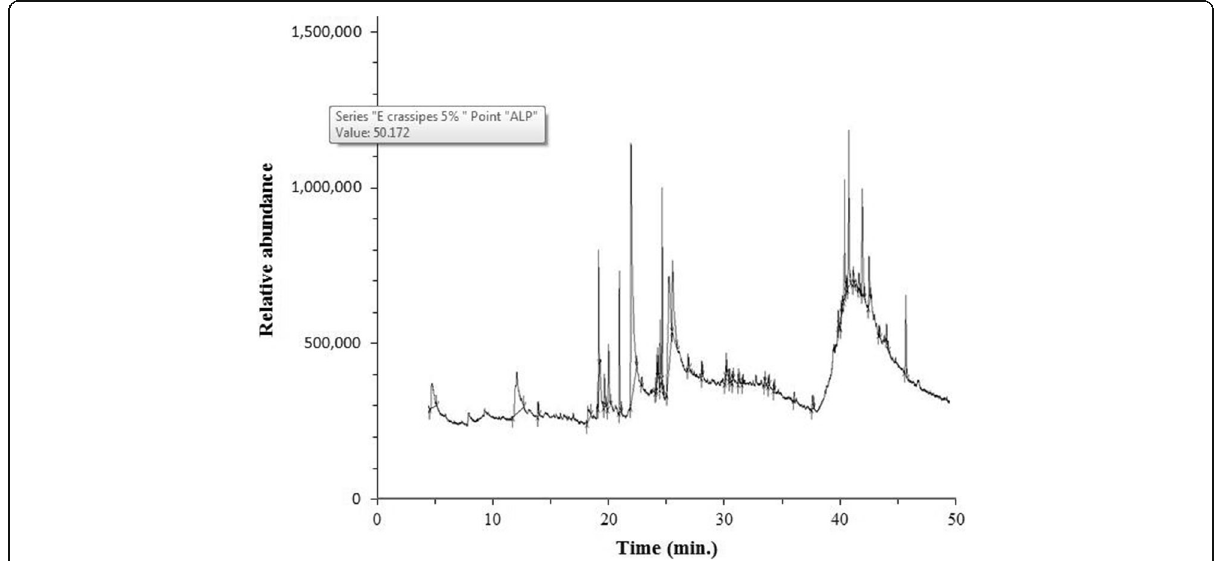
Fig. 1 GC chromatogram of methanol extract of E. crassipes